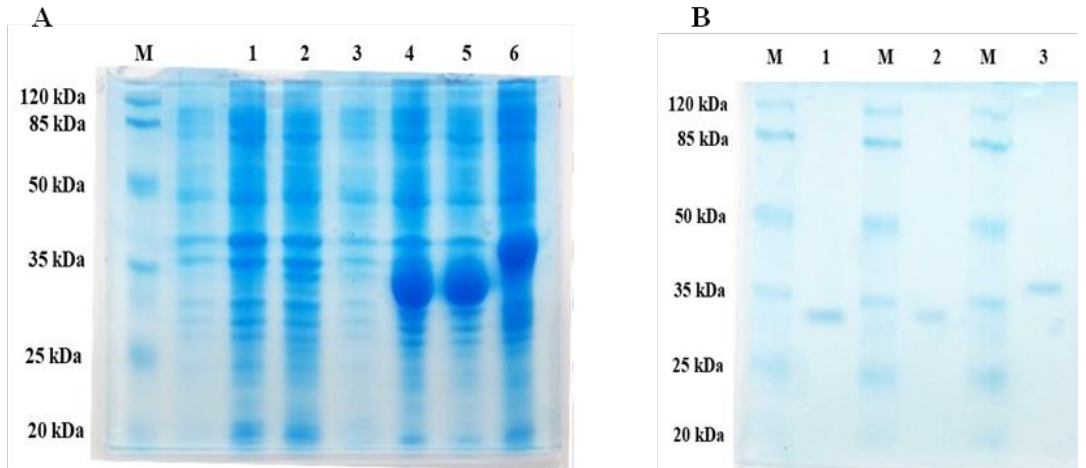
Figure 1. Expression and purification profiles (12% SDS-PAGE) of recombinant LIP3, LIP4, and PhaZ. ( A ) Cell lysates of Escherichia coli BL21 (DE3) transformed with pET28a-phaZ/lip3/lip4 Lane 1–3, cell lysate of uninduced E. coli BL21 (DE3) carrying phaZ-pET28a , lip3-pET28a and lip4-pET28a ; Lane 4, 5, 6, the lysate of the induced host cells containing phaZ-pET28a , lip3-pET28a and lip4-pET28a expressing PhaZ, LIP3, and LIP4, respectively.( B ) SDS-PAGE-purification profile after His–Tag affinity chromatography: PhaZ (Lane 1), LIP3 (Lane 2), and LIP4 (Lane 3); Lane M, standard molecular weight marker (Thermo Fisher Scientific, Waltham, MA, USA).